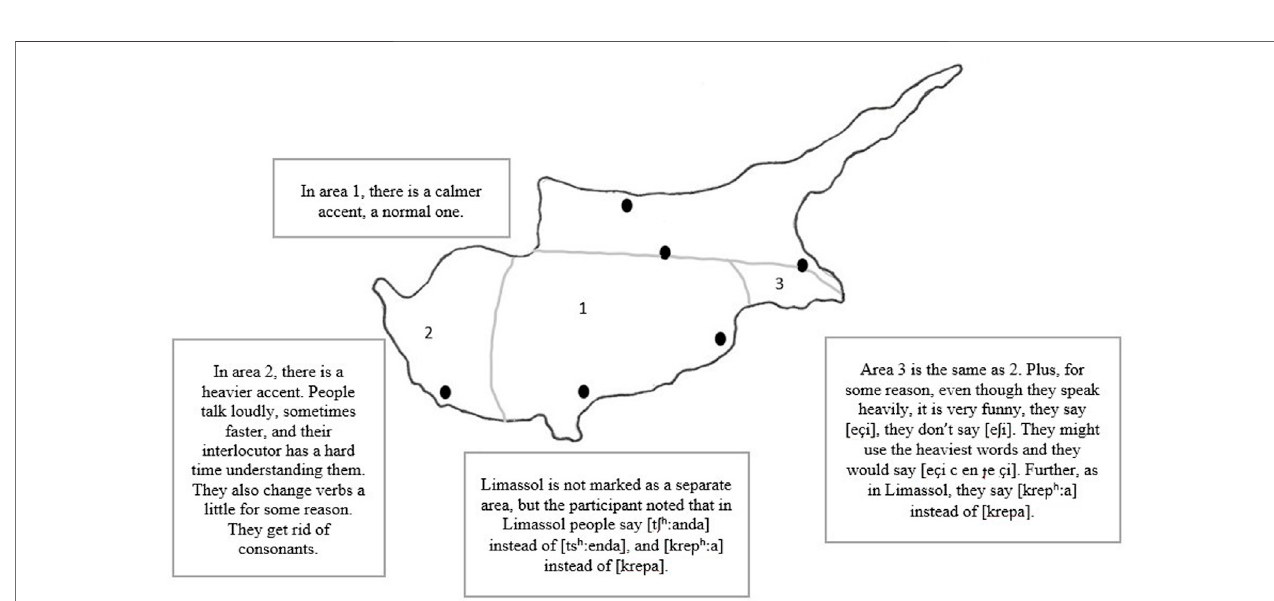
FIGURE 9 | Map drawn by participant